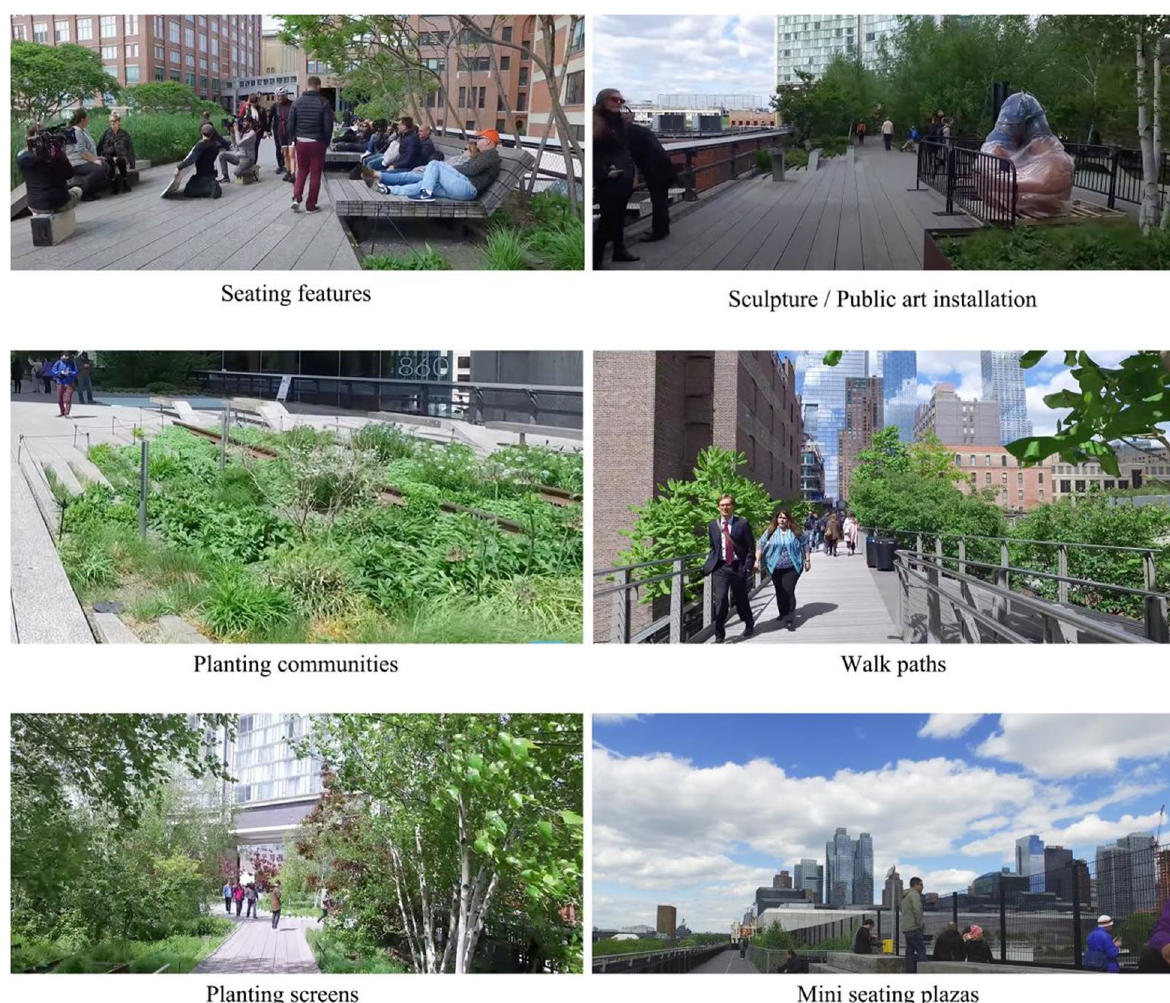
Fig. 9 Design feature of the HLP in the YouTube video by Wind Walk Travel (Source: https:// www. youtu be. com/ watch?v